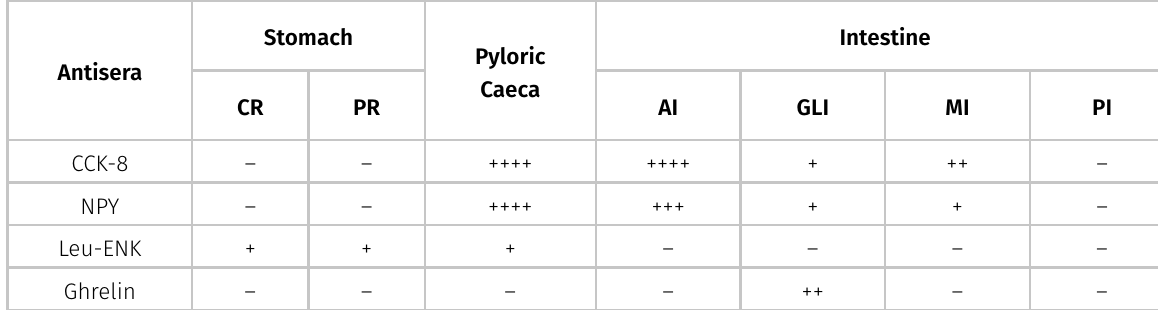
Note: CR, cardial region; PR, pyloric region; AI, anterior intestine; GLI, glandular intestine; MI, middle intestine; PI, posterior intestine. Intensity grades for the immunoreactions of endocrine cells: (–) not detected; (+) 1-10 cells; (++) 11-20 cells; (+++) 21-30 cells; (++++) more than 30